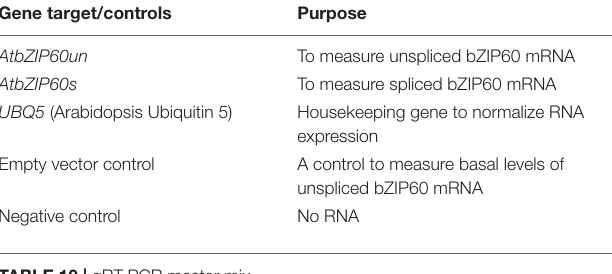
TABLE 9 | Target genes and controls used for qRT-PCR.